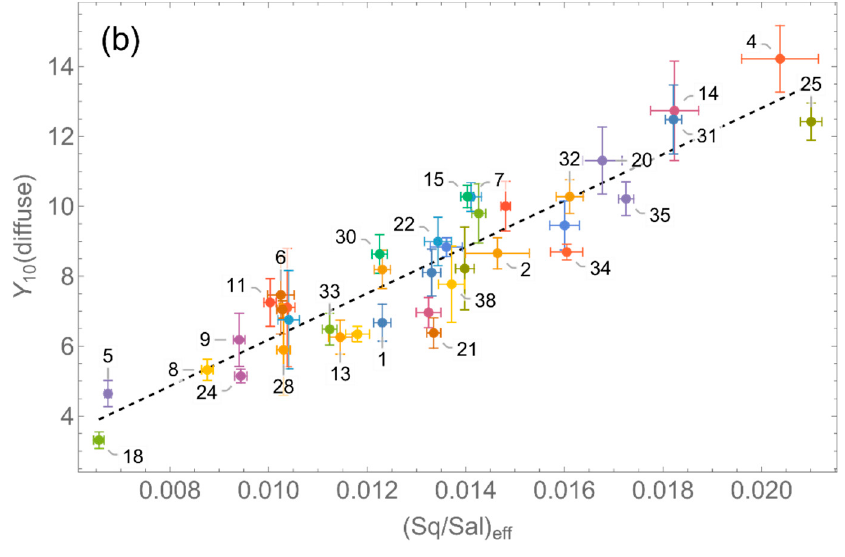
(cid:12) (cid:3020)(cid:3044) (cid:4698) , along (cid:12) , along with (cid:12) S al (cid:3020)(cid:3028)(cid:3039) (cid:3032)(cid:3033)(cid:3033) ef f